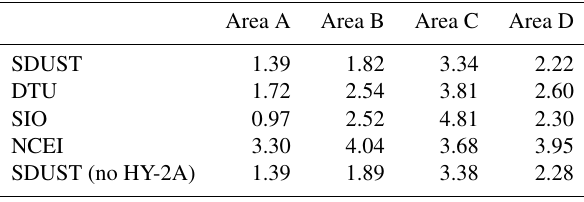
Table 4. Accuracy of altimeter-derived and shipborne gravity data in different areas (unit: mGal).